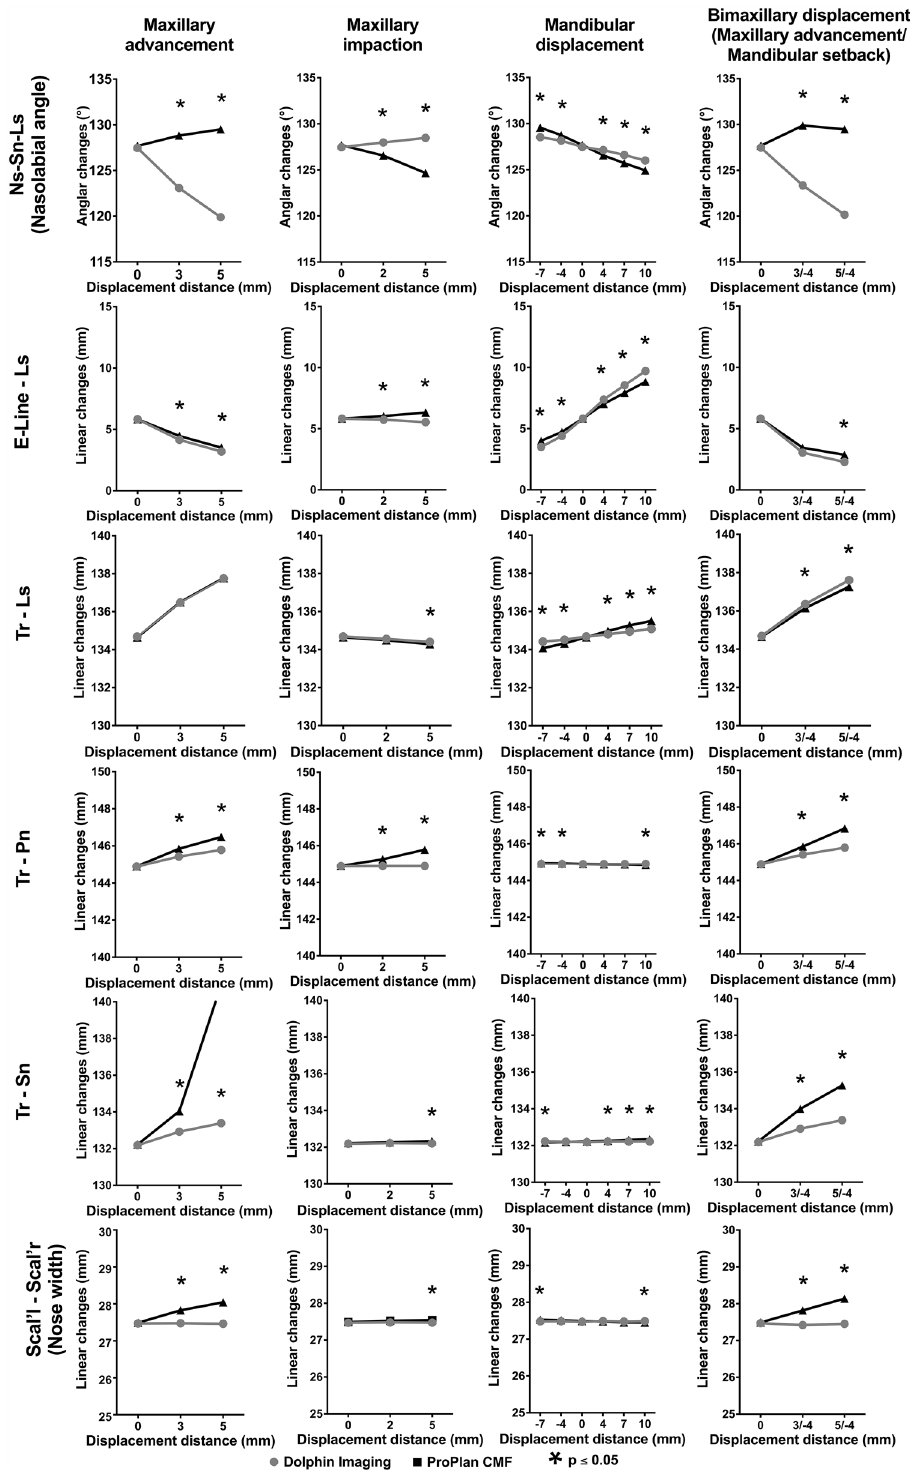
Figure 5. Line charts for the changes in the respective programs (ProPlan CMF vs. Dolphin imaging) in middle third of the face depending on surgical technique and displacement